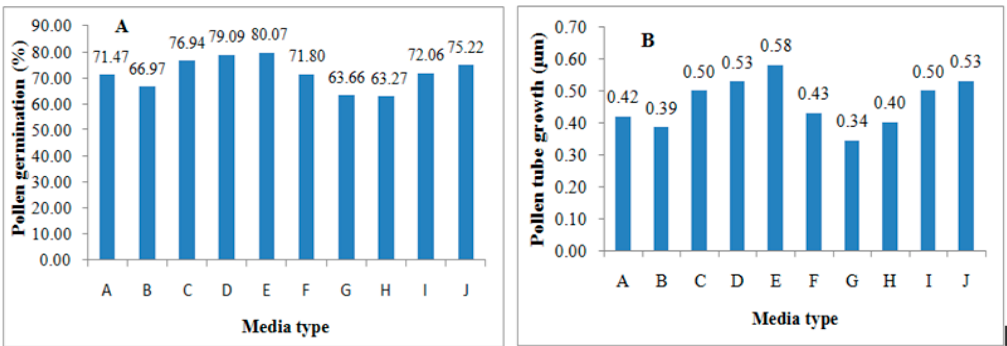
Figure 1. The effect of media types of sucrose, boric acid, and pH on pollen germination and tube growth ( A , B ). Media type A (control), B (sucrose 0%), C (sucrose 10%), D (sucrose 15%), E (boric acid 0.01%), F (boric acid 0.1%), G (boric acid 0.2%), H (pH level 4.5), I (pH level 5.0), and J (pH level 7.0).